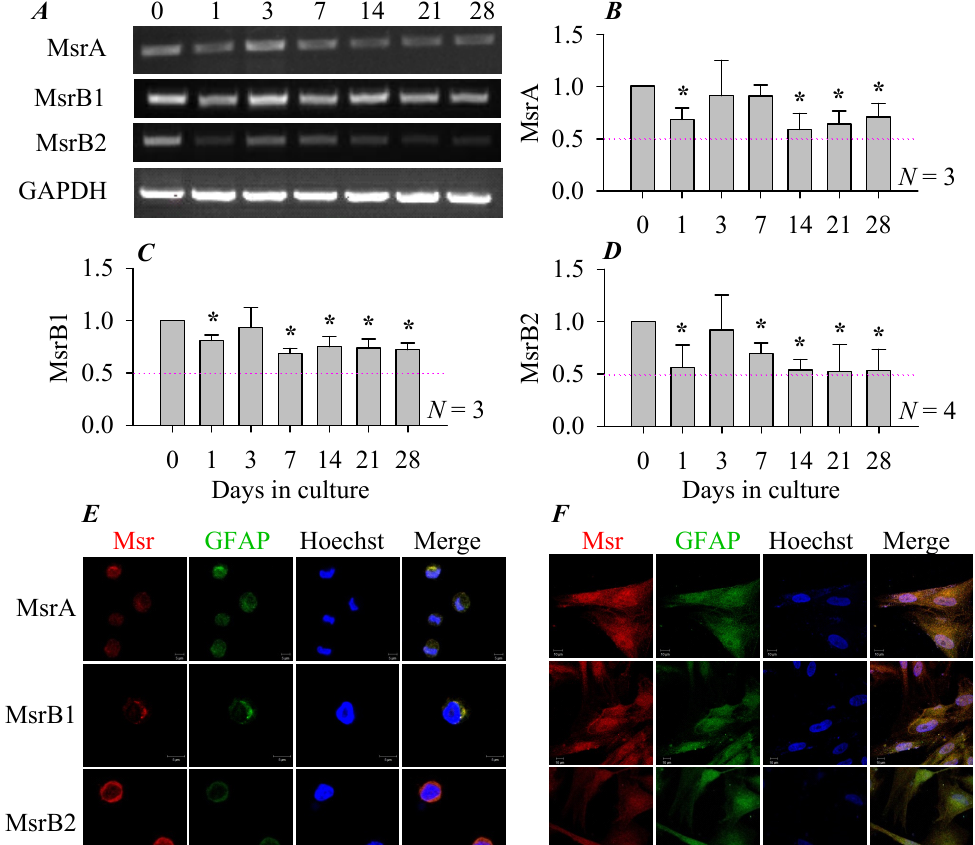
Figure 1. Msr expression in rat pancreatic stellate cells. RT-PCR was done as described in Methods and representative original images ( A ) and averaged Msr mRNA contents ( B – D ) are shown for rat pancreatic stellate cells cultured for 0, 1, 3, 7, 14, 21, 28 days. All data are expressed as Msr/GAPDH ratios normalized to that on day of isolation (day 0) (mean ± SEM, N = 3). The thin pink dashed lines indicate ratio 0.5. Asterisks ( * ) indicate statistical significance at p < 0.05, N ≥ 3 as indicated. The freshly isolated ( E ) or primary cultured (for 14 days) ( F ) rat pancreatic stellate cells were fixed and immunocytochemistry done. Primary antibody: anti-MsrA, B1, B2, GFAP; secondary antibody: TRITC-tagged donkey anti-rabbit, DyLight 488-tagged donkey anti-goat antibody. Nucleus was counter-stained with Hoechst 33342. Confocal images were taken in a Zeiss LSM 510 META (objective 63 × /1.40 oil), with λ ex TRITC/543 nm, Hoechst 33342/405 nm. No fluorescence was detected